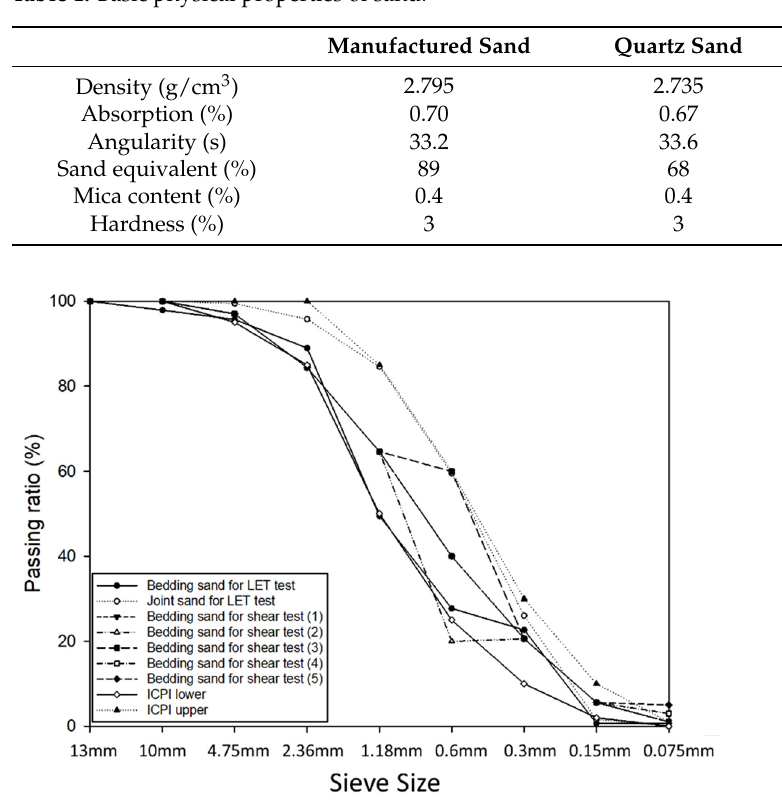
Figure 2. Distribution of particle sizes of bedding sand and joint sand.